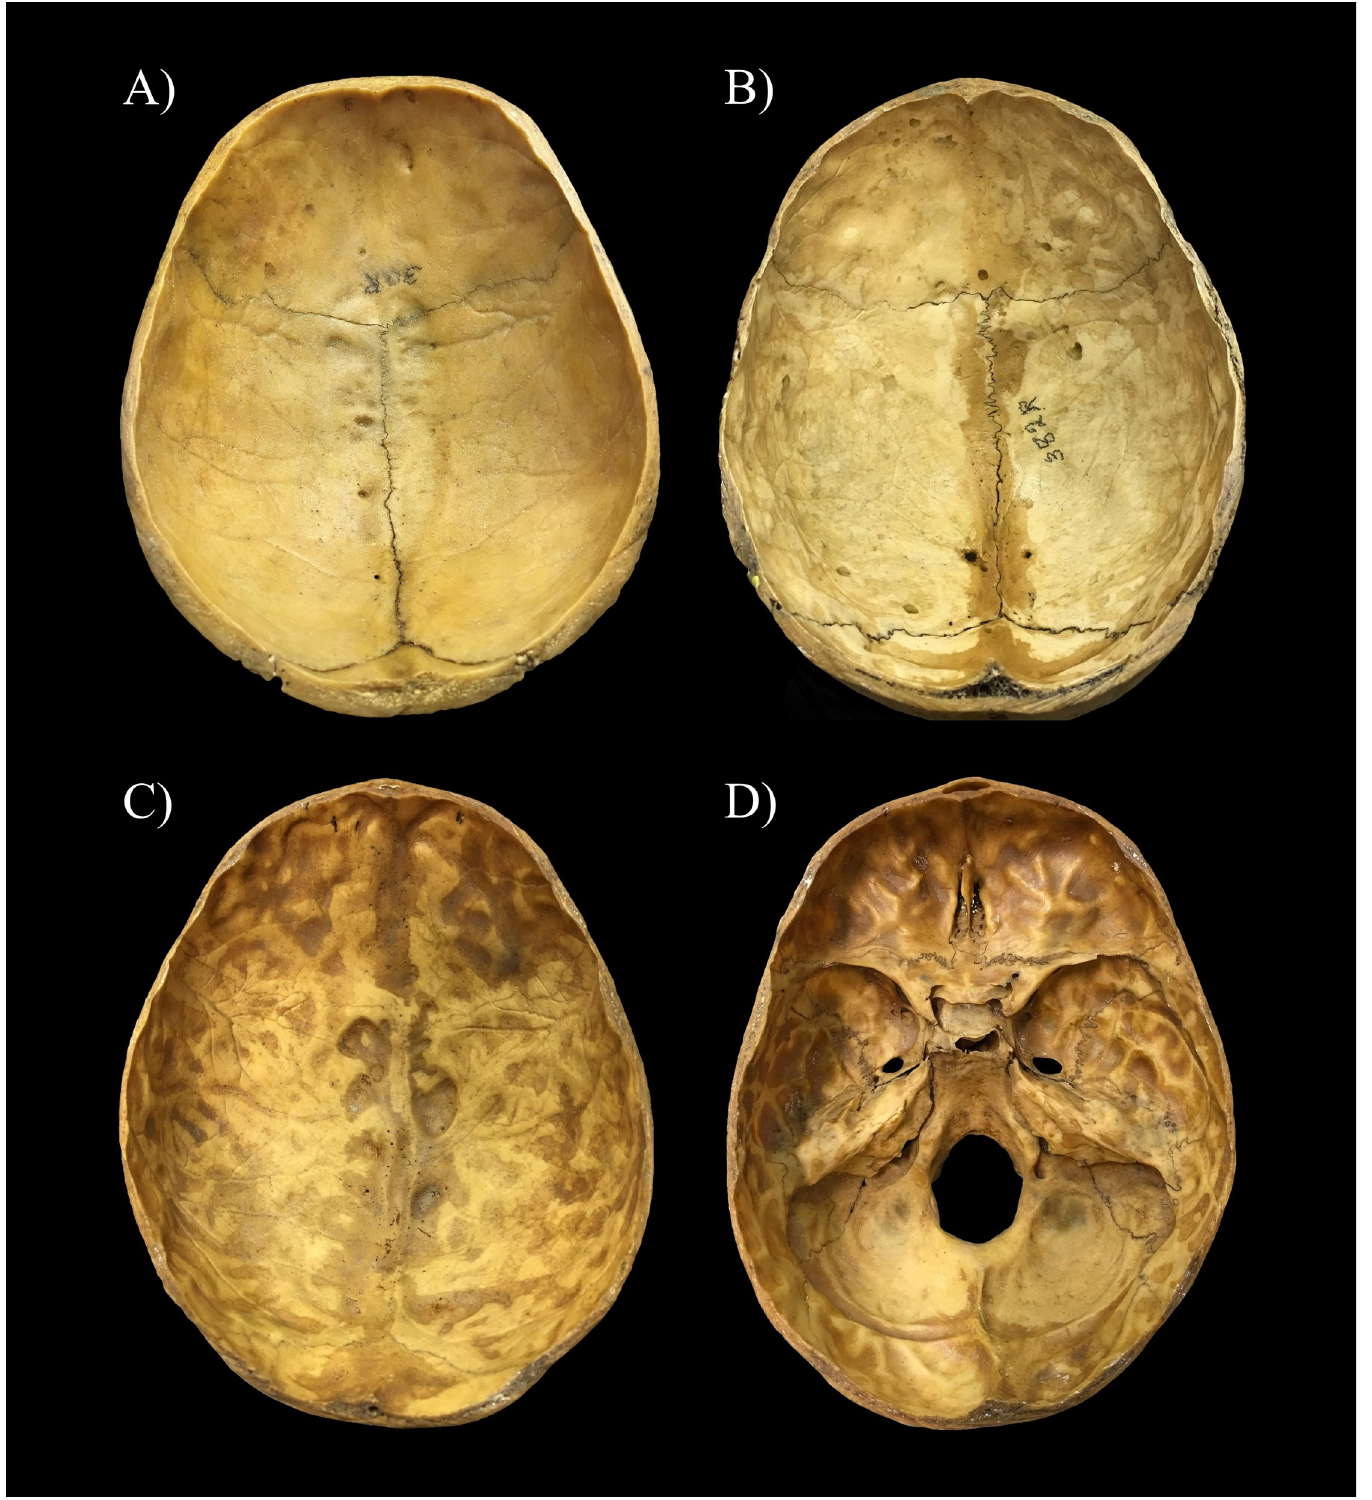
Fig 1. Reference cases selected for the classification of individuals exhibiting APDIs on the endocranial surface of the skull. A) Very slight stage represented by shallow DIs predominantly localized over the anterior portion of the inner skull surface (Terry No. 30R: 26-year-old, male, died of TBM–skullcap); B) Slight stage represented by deeper DIs particularly situated over the anterior and middle portions of the endocranial surface (Terry No. 382R: 26-year-old, male, died of pulmonary